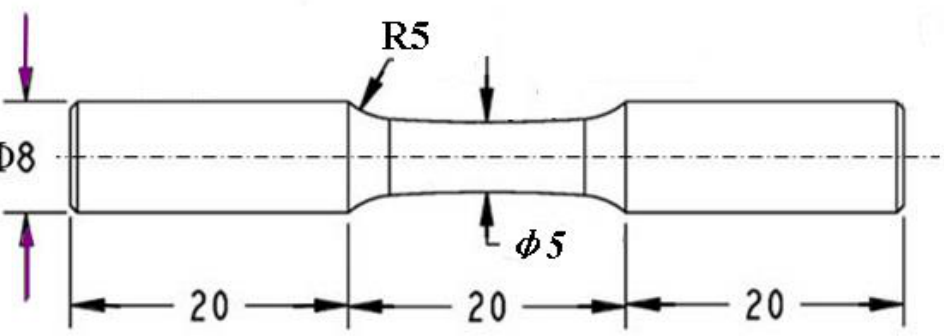
Figure 1. Dimension of the rotating–bending fatigue samples (in